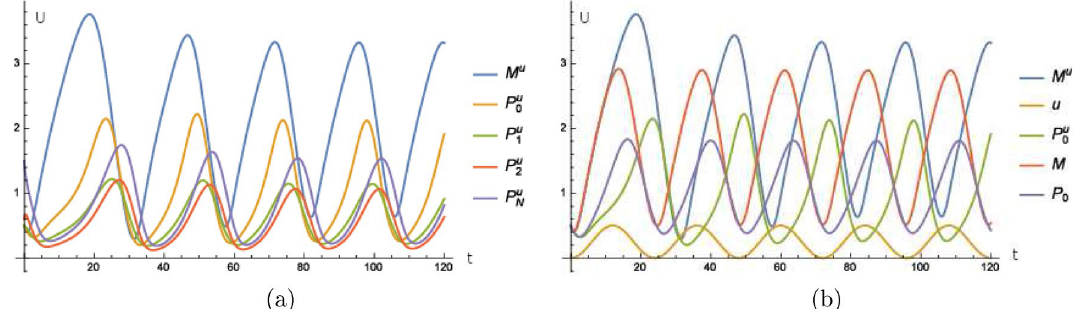
Figure 3. A further digestion of PER protein shifts the phase of the molecular clock. ( a ) Time curves where the superscript u indicates that these time curves stem from the extended model consisting of (1) to (5) where (2) is replaced by (8) for (16) and α = 1 . ( b ) Time curve of the external stimulus u defined in (16), of M and P 0 calculated from the model (1) to (5) and of M u and P u 0 calculated from (1) to (5) where (2) is replaced by (8) for (16) and α = 1 . Units and dimensions: abscissa t : time in hours, ordinate U : amount of substance ( M , M u mRNA, P u i , { 0, 1, 2, N } , protein, u intensity of